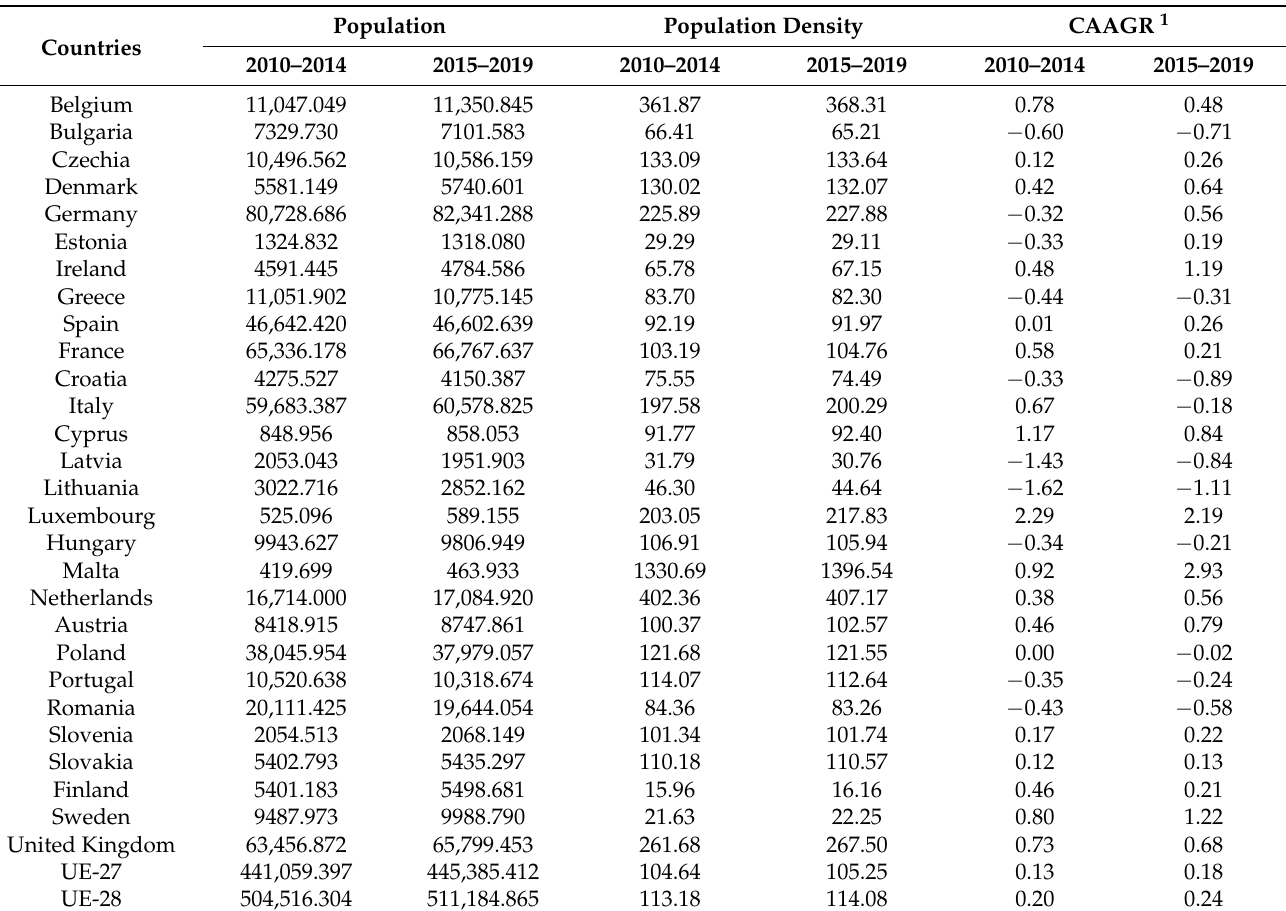
Table 1. Population (number of persons), population density (number of inhabitants per square kilometre), population growth rate